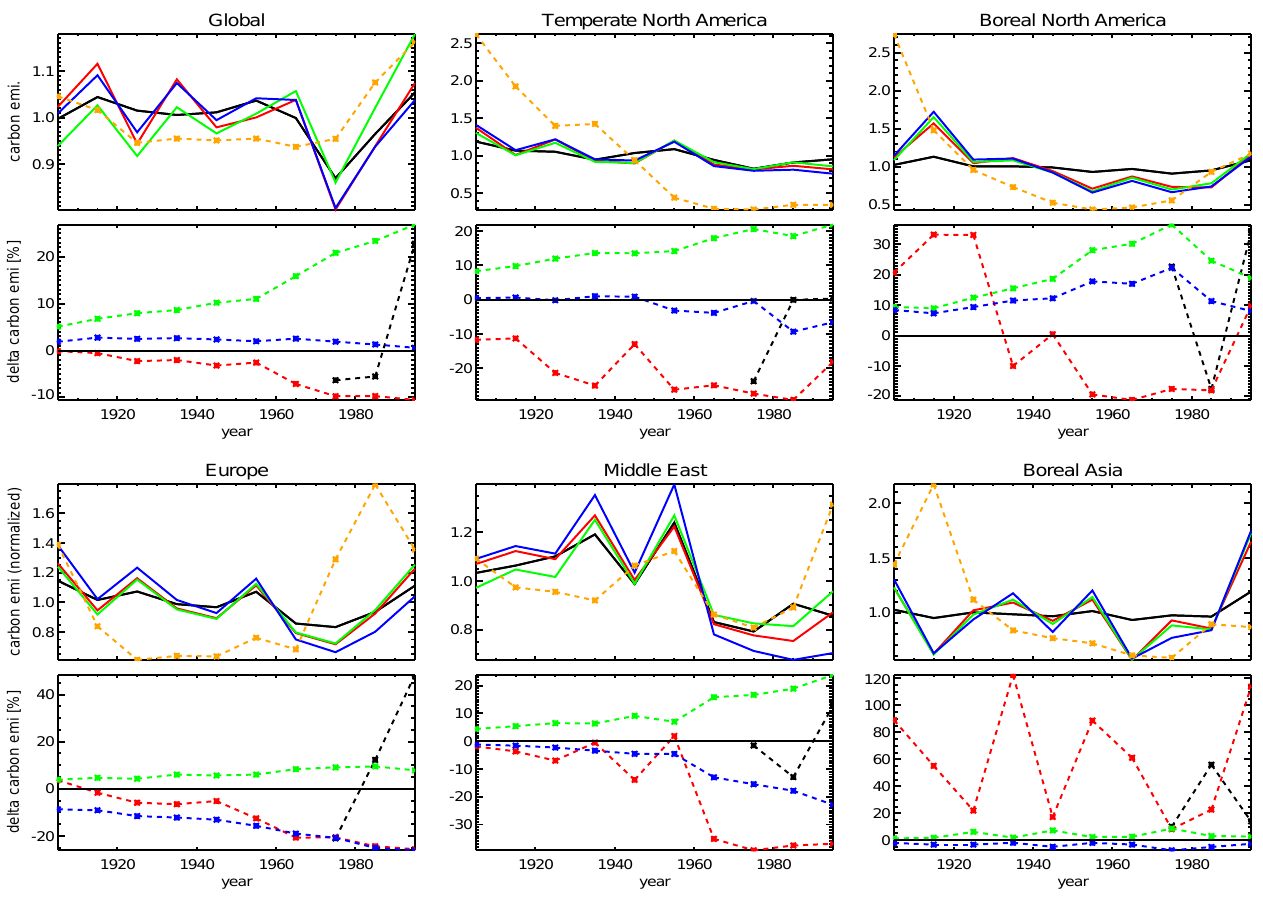
Fig. 10. Upper panels: Trend in decadal total (wildfire and deforestation) fire carbon emissions compared to decadal mean GICChist estimates (Mieville et al., 2010) for different regions from 1900 to 2000 normalized with the mean value for 1900–2000. Solid lines represent model simulations: black: T-FULL, red: AB-FULL, green: AB-HI; blue: AB-HI-FS. Dashed orange line with symbols are observations (GICChist); Lower panels: decadal mean change in total carbon loss in [%] with respect to the respective control simulation caused by red: land use change and wood harvest, green: human ignition, blue: human ignition and fire suppression, black: climate. Note here, that the fire carbon-system is highly non-linear and therefore the individual responses are not additive.